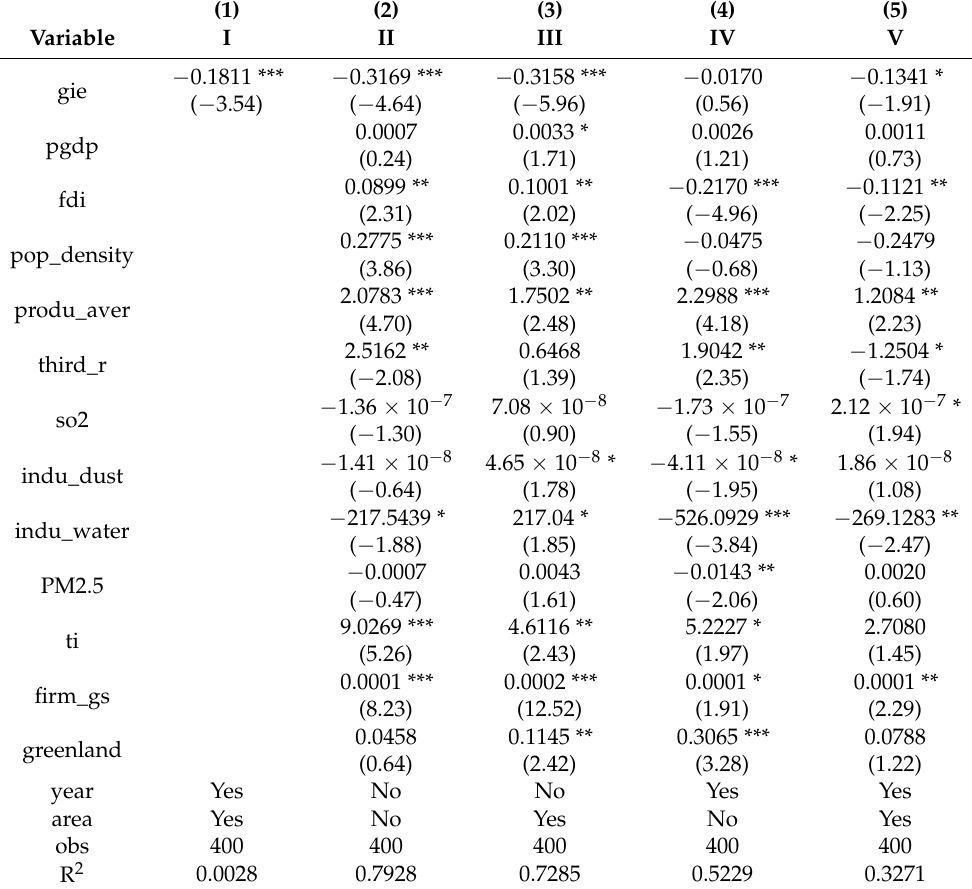
Table 2. Benchmark regression